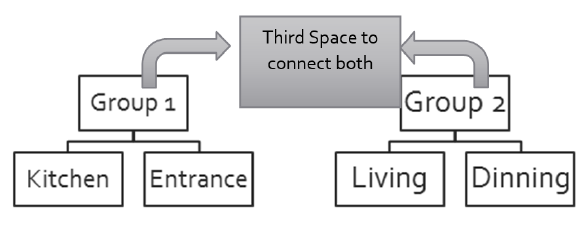
Figure 28. Ahmet Vural prototype that existed in Efruz housing and Macit Ferdi house. (Developed by Author).